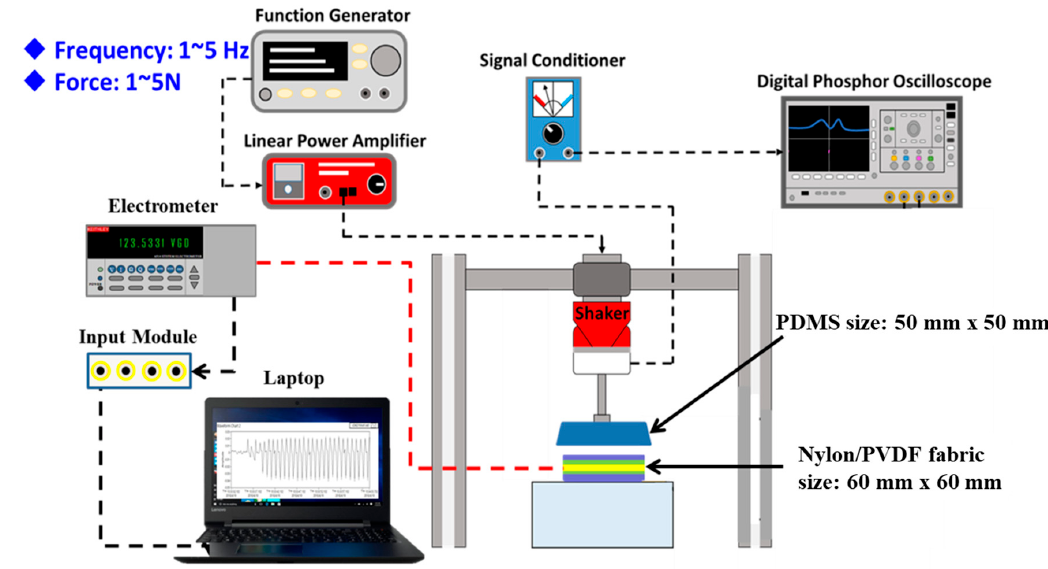
Figure 3. Schematic of the standard dynamic testing platform used to measure the electrical output of the WTENG under different applied forces and frequencies.